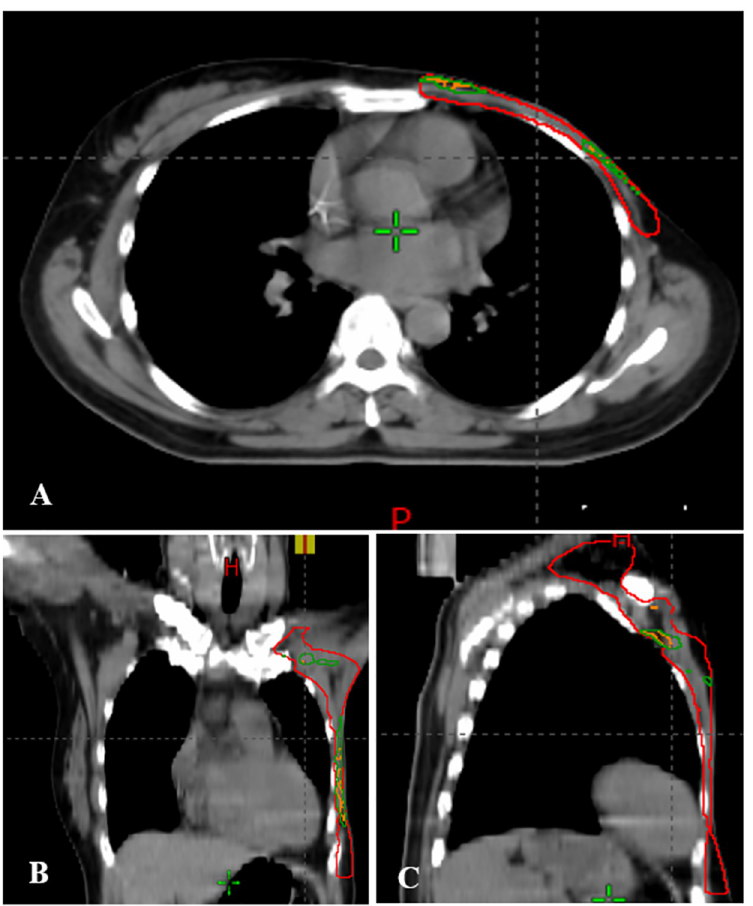
Fig 4. Underdosed volumes in CTV (red) in VMAT-5B (orange) and VMAT-10B (dark green) with setup errors in the posterior direction for a typical